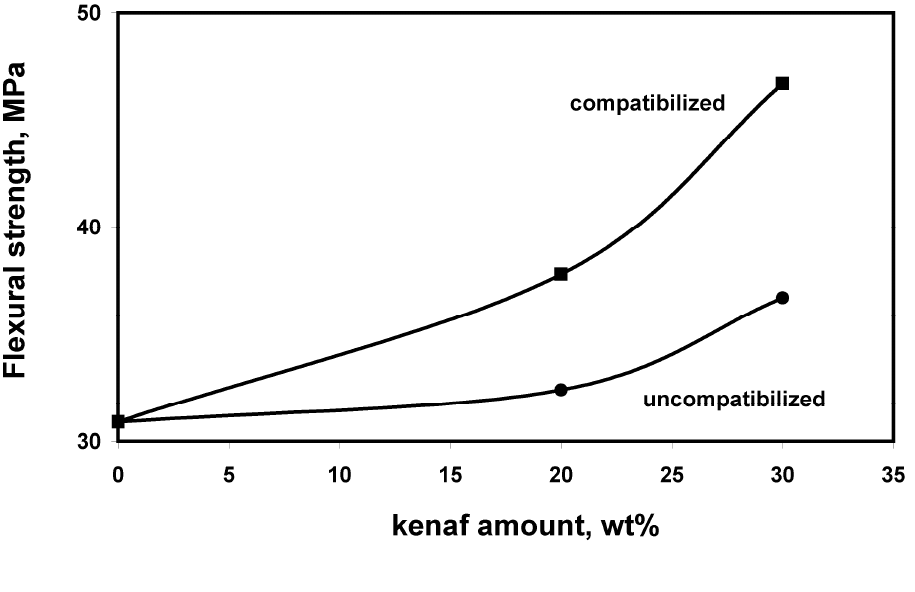
Figure 3. Flexural strength of PLA based composites as a function of the kenaf content and the compatibilization.